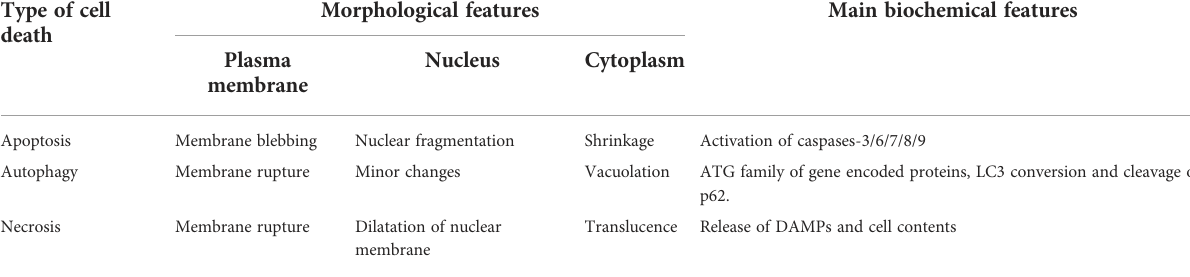
TABLE 1 The distinctive morphological and main biochemical features of apoptosis, autophagy, and